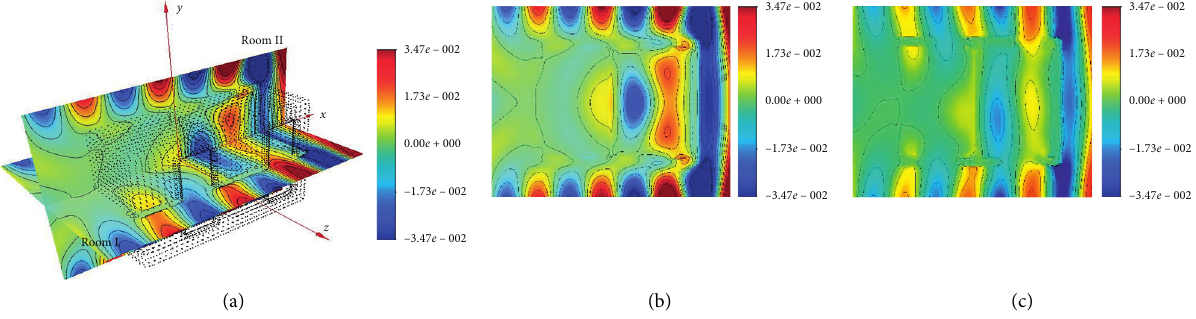
Figure 3: The isometric (a), x - y plane (b), and x - z (c) plane view of the rooms for 300MHz.